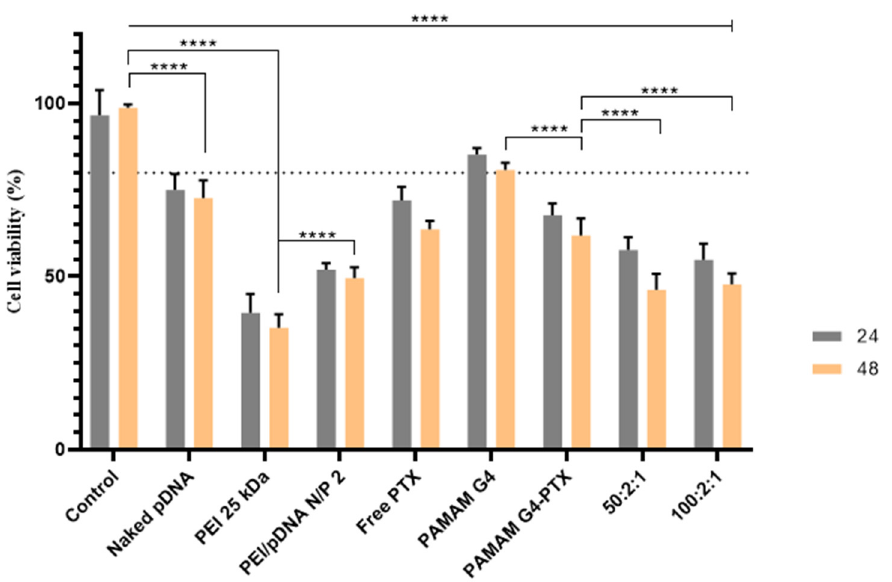
Figure 4. Viability of HeLa cells after 24 and 48 h incubation with naked pDNA, PEI 25 kDa, PEI/pDNA complexes at N/P ratio of 2, free PTX, PAMAM G4, PAMAM G4-PTX and PAMAM G4-PTX/pDNA/PEI complexes at N/P ratios of 50:2:1 and 100:2:1. Non-transfected cells were used as negative control for cytotoxicity. Statistical analysis was made using “one-way ANOVA” with data obtained from four independent measurements (mean ± SD, n =